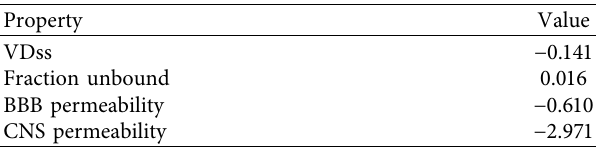
Table 8: Distribution properties of the alternaramide marine cyclopentadepsipeptide.